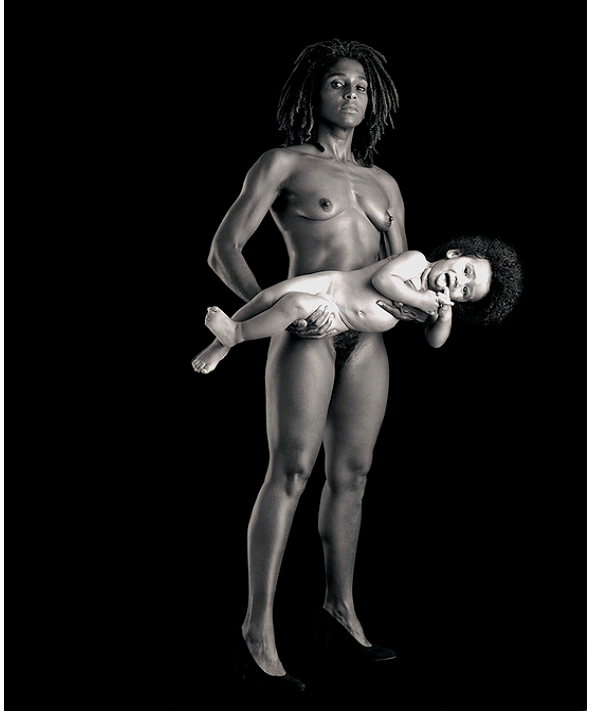
Figure 3. Cox’s Yo Mamma , 1993. “The artist grants permission to download the artist’s images from the website for non ‐ commercial use or for fair use as defined in the United States copyright